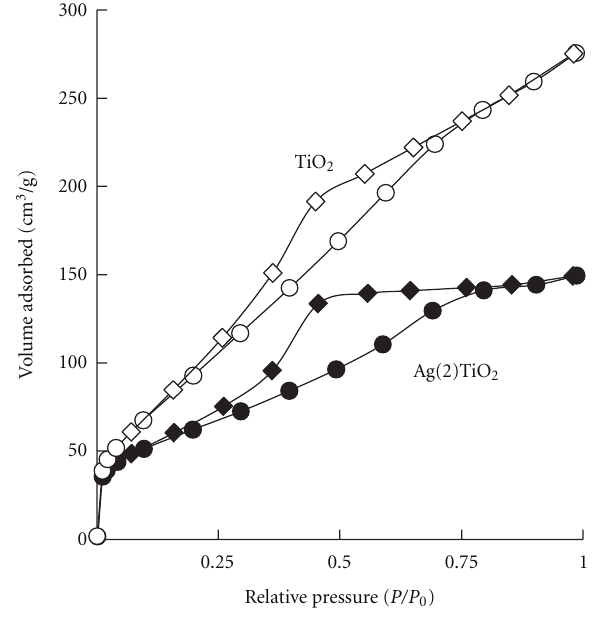
, (cid:4) ) absorption, ( (cid:0)